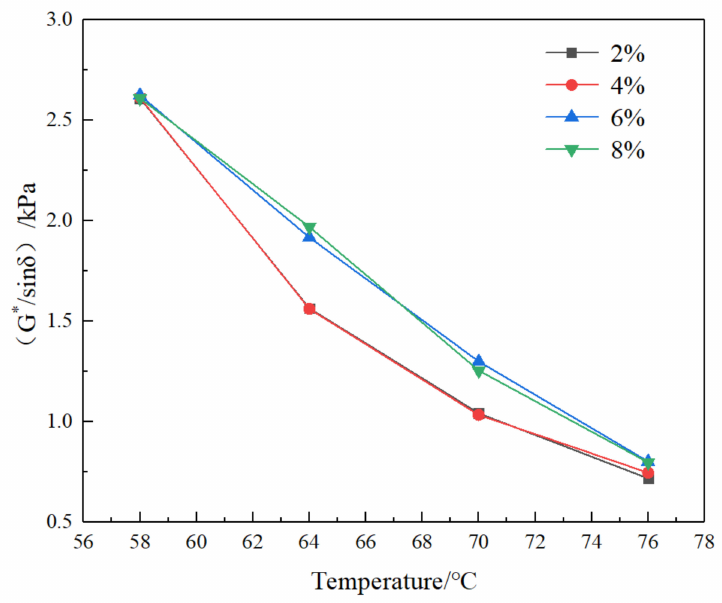
Figure 2. Curves of factor G * / sin δ of bitumen with di ff erent SF content with